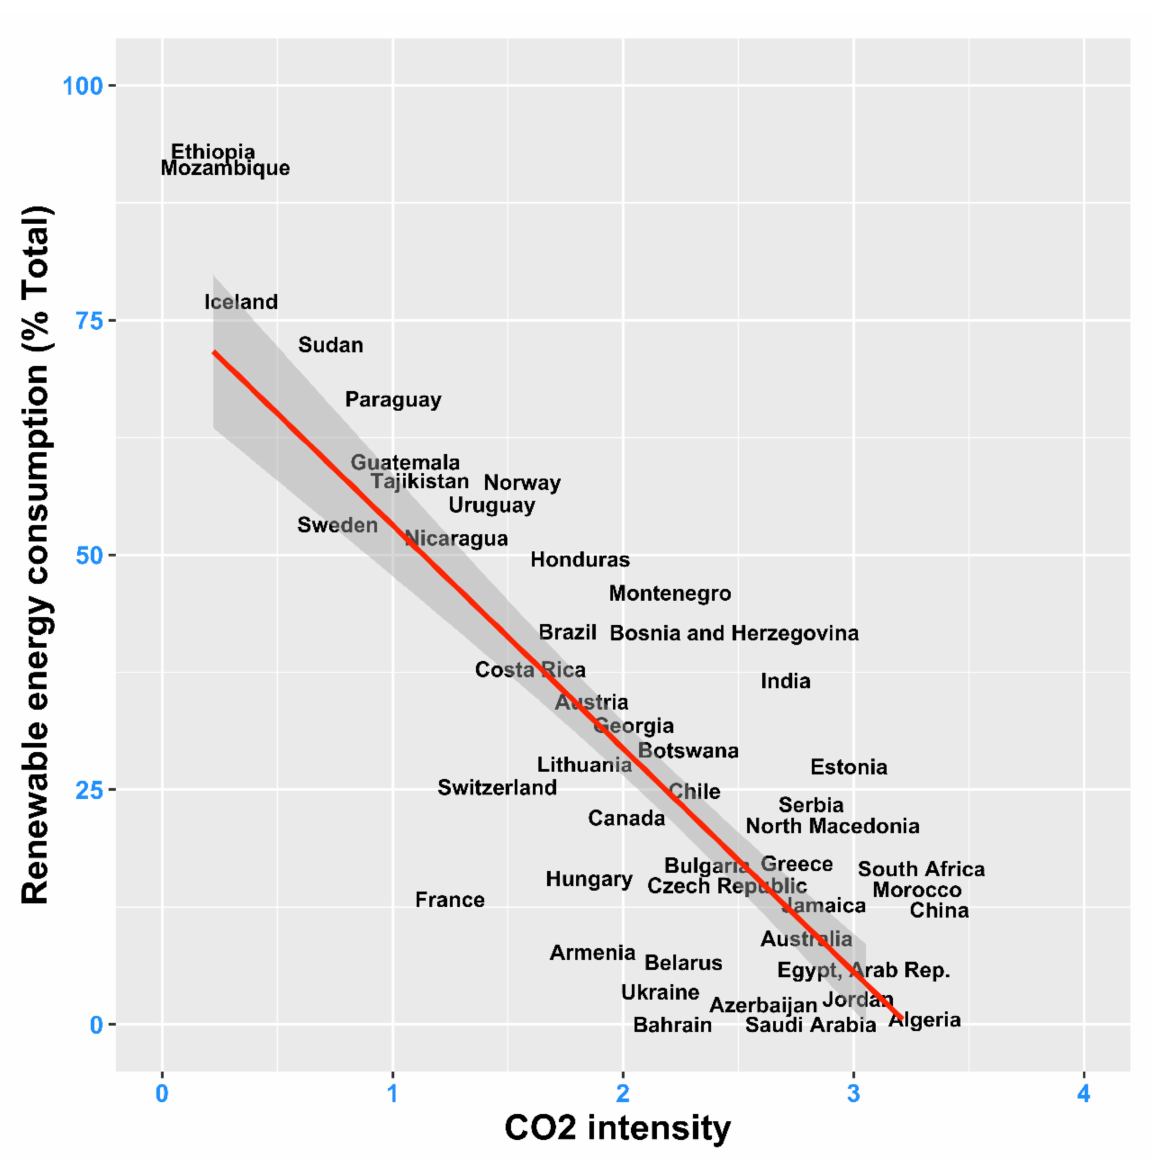
Figure 4. Carbon intensity and renewable energy consumption (REC), most recent year of available data per country. Source of data: World Bank’s Development Indicators (WDI)